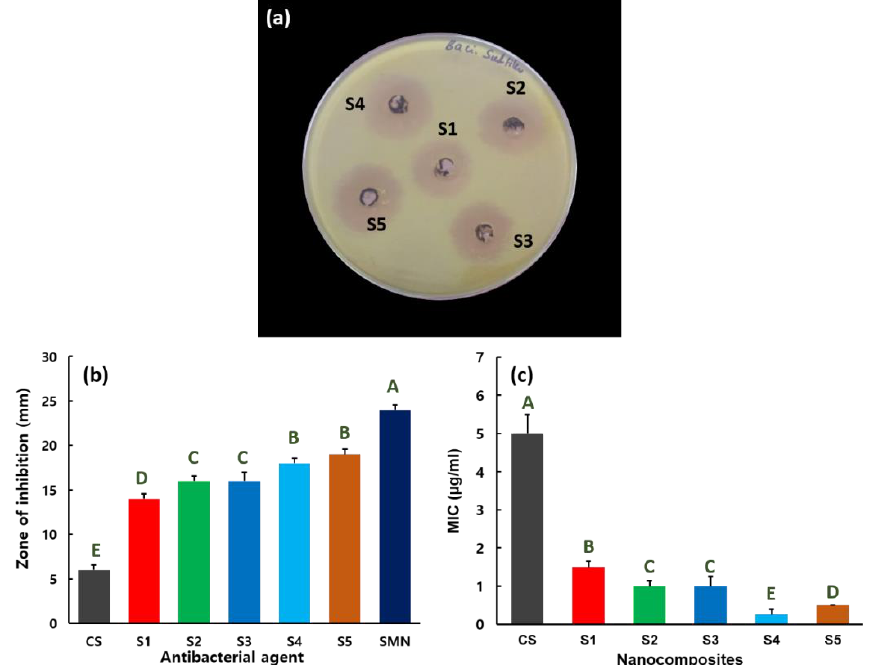
Figure 4. ( a ) Antibacterial activity of nanocomposites S1–S5 versus B. subtilis . ( b ) Zone of inhibition for chitosan (CS), streptomycin (SMN) and nanocomposites S1–S5, stated as mean ± SD from the results of triplicate tests. Statistical analysis indicated that the values are significantly ( p ≤ 0.05) varied between their experiments, which are indicated by capital letters. ( c ) Minimum-inhibitory-concentration (MIC) values for CS and nanocomposites S1–S5 versus B. subtilis , expressed as mean ± SD from the triplicate tests. Statistical analysis indicated that the values are significantly ( p ≤ 0.05) varied between their experiments, which are indicated by capital letters.